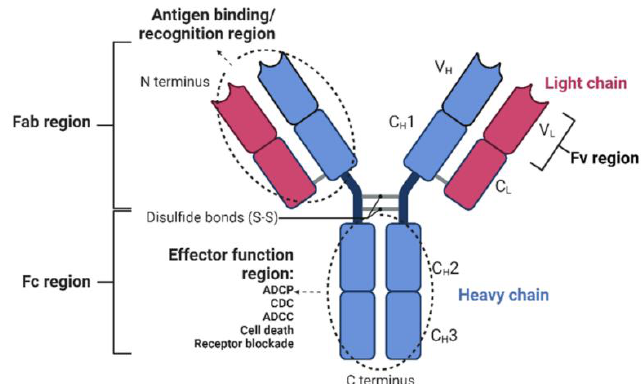
Figure 1. Monoclonal antibody (mAb) structure. ADCP: antibody-dependent cell phagocytosis; CDC: complement-dependent cytotoxicity; ADCC: antibody-dependent cell cytotoxicity; C: constant; V: variable; L: light chain; H: heavy chain.